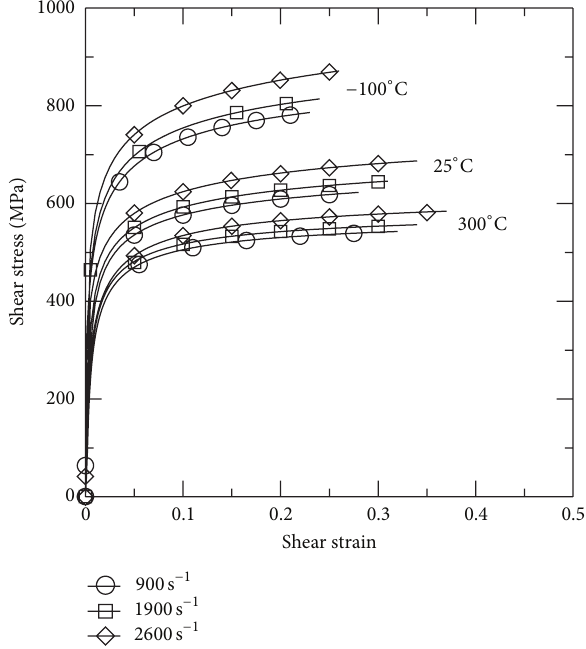
Figure 2: The shear stress-strain curves of Inconel 690 alloy deformed at different strain rates and temperatures.